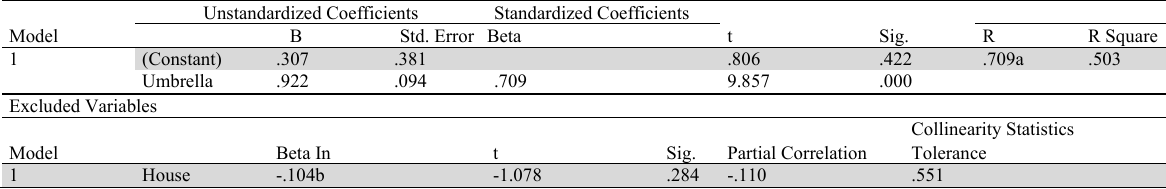
The results of the regression